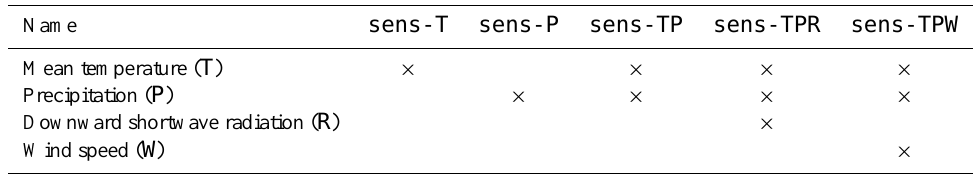
Table 1. Combinations of driving variables that are allowed to vary in the sens-* runs. Each column is a separate run. All driving variables not marked with an “ × ” are set to their daily climatology.